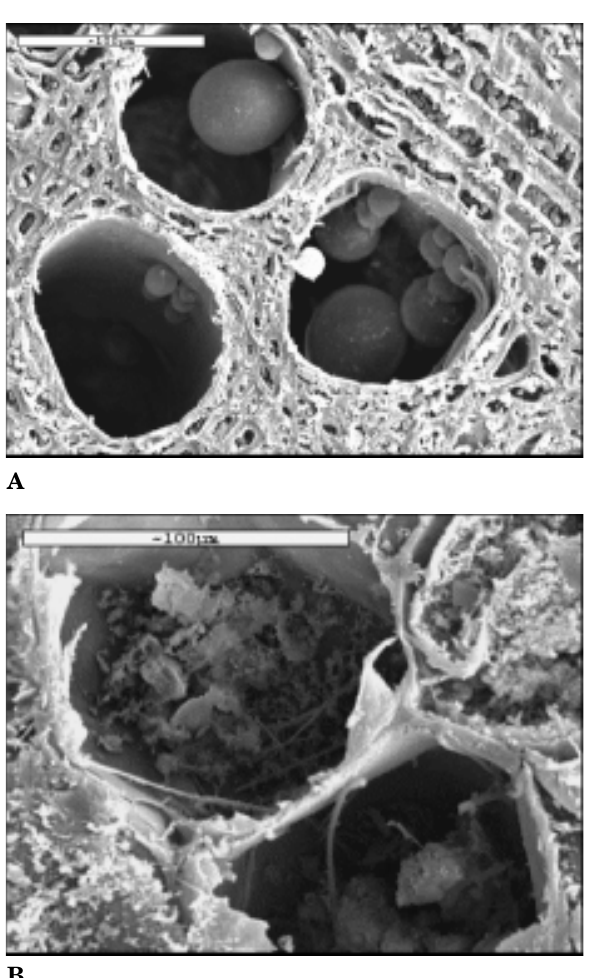
Fig. 2. Scanning electron micrographs of a cross-section of the same Richter 110 rootstock as in Fig. 1. A. Tylos- es formation in the xylem lumen ( (cid:1) 450). B. Deposition of aggregates in the xylem lumen ( (cid:1) 600).